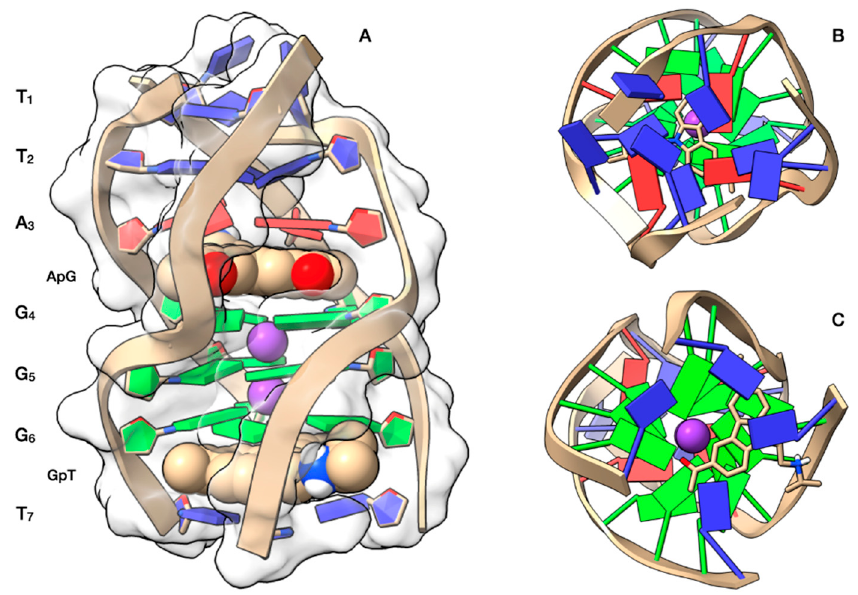
Figure 4. Graphical representations of the curaxin-d(TTAGGGT) 4 complexes at the ApG and GpT intercalation sites, obtained by Molecular Docking and optimized by Molecular Dynamics (MD). ( A ) Side view of the ghostly white solvent accessible surface (SAS) of the d(TTAGGGT) 4 quadruplex. The nucleotides are represented in stick and filled rings: adenine in red, guanine in green and thymine in blue. The ligand is represented as van der Waals (vdW) spheres and colored following the CPK code. The optimized conformations of the ligand are represented in ( B ) for the complex at ApG and in ( C ) for the complex at GpT. Potassium ions are represented by their vdW spheres (K + in purple), while the ligand is depicted in stick and colored following the CPK code. The nucleotides are represented as filled plates: adenine in red, guanine in green and thymine in blue.